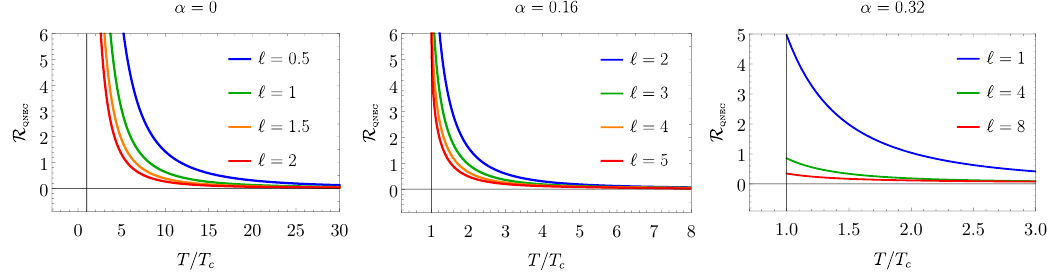
Figure 18 . QNEC non-saturation ratio R QNEC as function of temperature T > T c for various values of interaction strength α and interval length